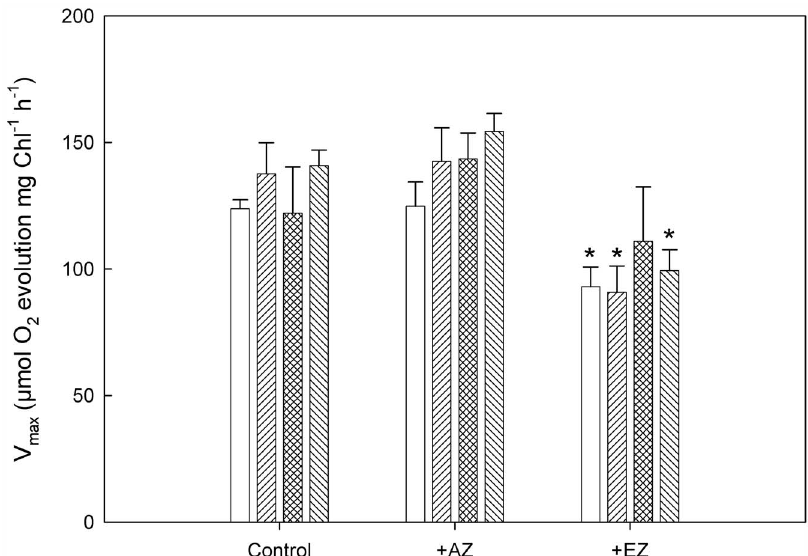
Figure 3. Change in maximal rate of photosynthetic oxygen evolution (V max ) as determined from C i -response curves using the Michaelis-Menten equation for determination of V max . The bar legend is: no fill = Low C i hatch fill diagonal left= High C i , hatch fill both diagonals = Low C i + EE2 and hatch fill diagonal right = High C i + EE2. The irradiance during all measurements was 180 m mol quanta m 2 2 s 2 1 while the C i -response curves were determined by successive addition of HCO 3 2 from 0 up to 3.1 mM in 10 steps. Data represent means 6 SE, n=4–6. * above a bar indicates a significant change as compared to the control using a student’s t-test and p , 0.05.